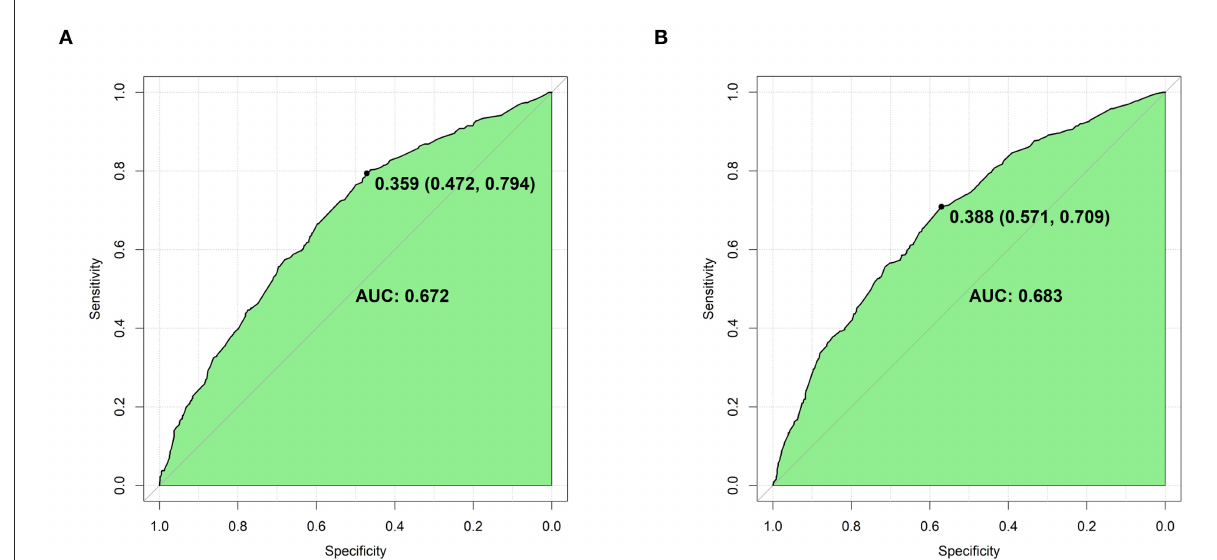
FIGURE4 Area under receiver operation curve (AUROC) for the nomogram in the two groups. (A) The training group (AUROC = 0.67); (B) the validation group (AURCO = 0.68). The curve was plotted with one specificity against sensitivity.